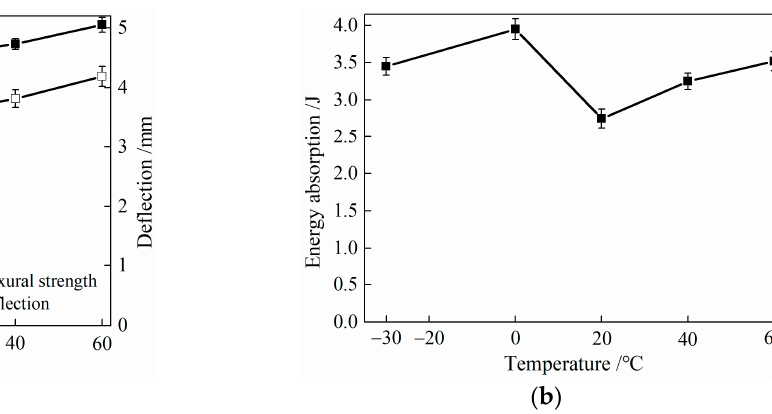
Figure 17. Relationship between feature parameters of flexural property and temperature for HDC. ( a ) Flexural strength and deflection. ( b ) Energy absorption.